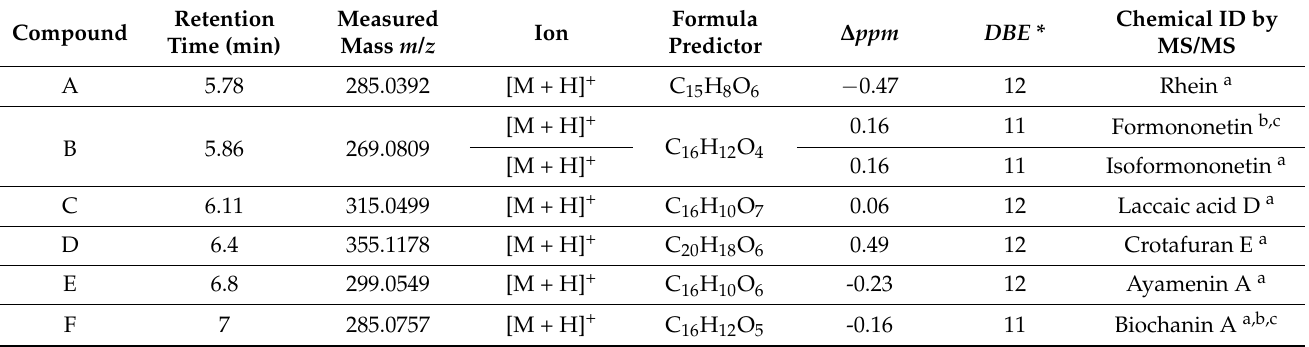
Figure 6. Microbroth susceptibility assay of sixteen KADAMEI3I7 HPLC fractions (64 µ g/mL), tetracycline (32 µ g/mL, positive control), and vancomycin (2 µ g/mL, positive control) against MDRSA. The data illustrated are average % growth inhibition (± SEM) of the samples against S. aureus ATCC BAA ‐ 44. Error bars are standard error of the mean. Assay was conducted in three replicates and in three trials. KADAMEI3I7 is the mother fraction of the sixteen HPLC fractions tested. Table 2. HRMS profile of the six C. cajan seed metabolites showing the retention time, exact masses, chemical formulae, double bond equivalent, and putative